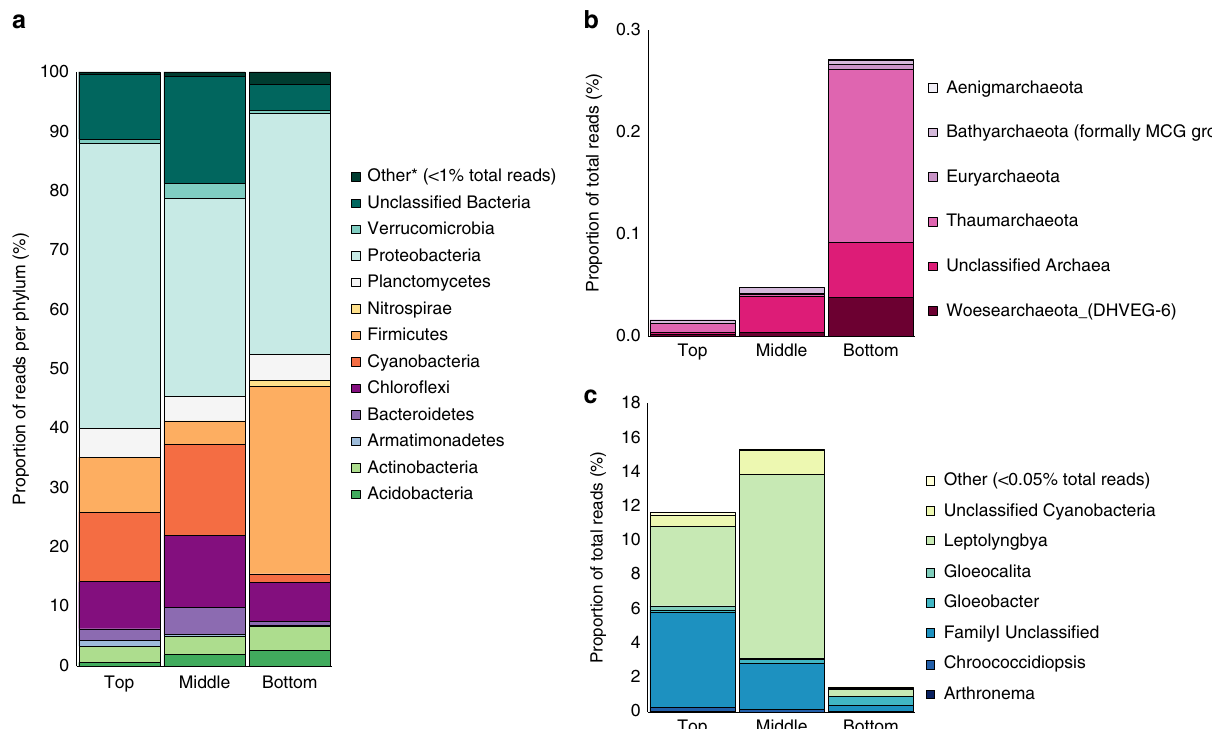
Fig. 3 Composition of the Balambano mat microbial community. Distribution of Illumina 16S rRNA gene sequences are shown per bacterial phylum (a ), per archaeal phylum (b ) and per cyanobacterial genera ( c ), in three sections of the microbial mat (top = 0 – 2 mm; middle = 2 – 5 mm; ottom = 5 – 20 mm). The number of sequence reads per phylum is calculated as a percentage of the total sequence reads for each sample. *Other represents reads that contributed <1 and 0.05% of the total number of reads for A and C,